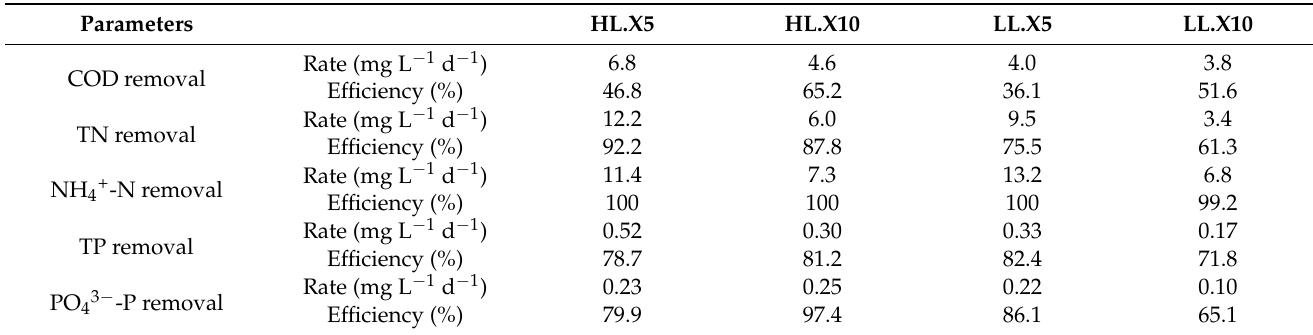
Table 3. Treatment performance including removal rate and removal efficiency under the impacts of light and nutrient